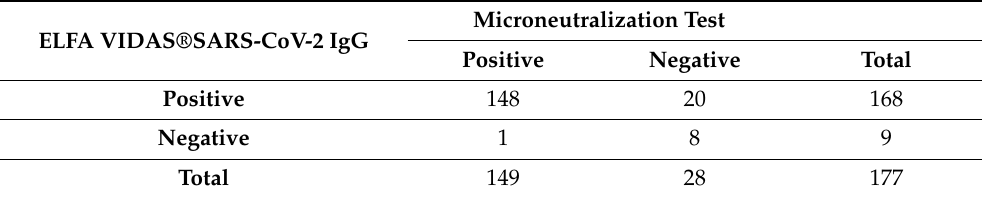
Table 2. Determination of the concordance of VIDAS ® SARS-CoV-2 IgG for the detection of anti-SARS- CoV-2 IgG antibodies and microneutralization assay for the detection of neutralizing antibodies. Microneutralization Test ELFA VIDAS®SARS-CoV-2 IgG Positive Negative Total Positive 148 20 168 Negative 1 8 9 Total 149 28 177